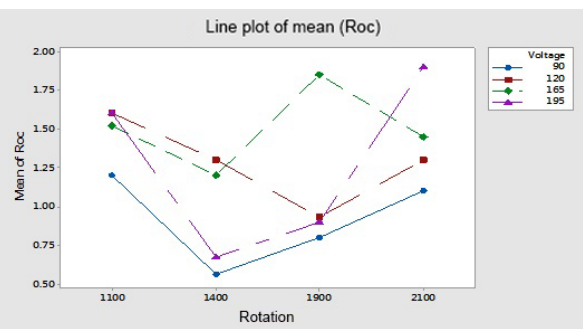
Figure 12. OC 1 S/N graph for the cryogenic tool.